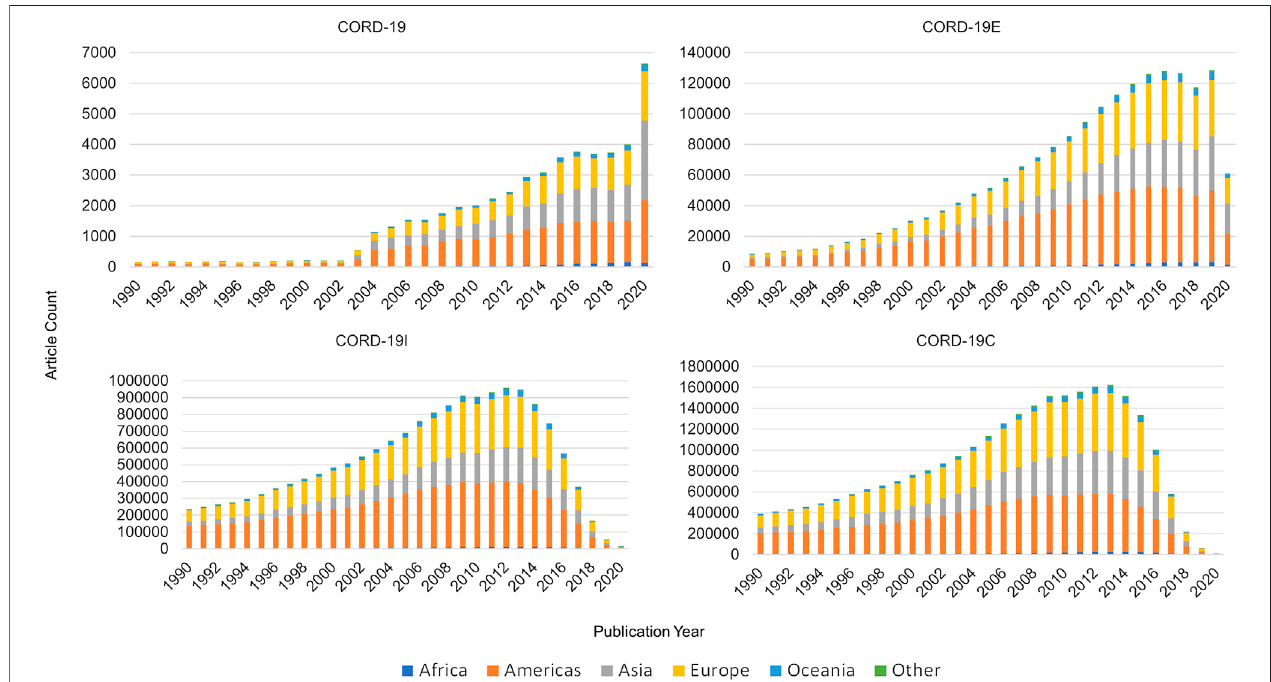
FIGURE 9 | Article counts per year by continents for COVID-19 Research Dataset (CORD-19) and the three expanded datasets.